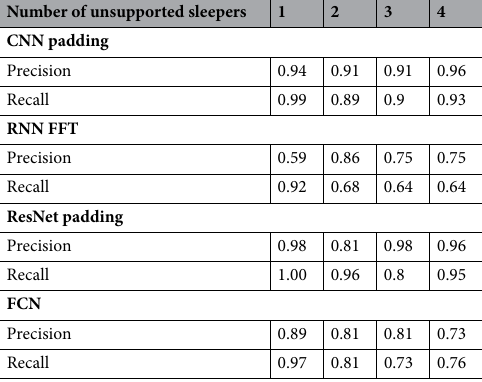
Table 8. Precision and recall of each model of severity classification.